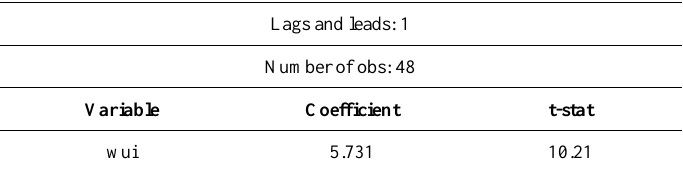
Table 4. Panel DOLS